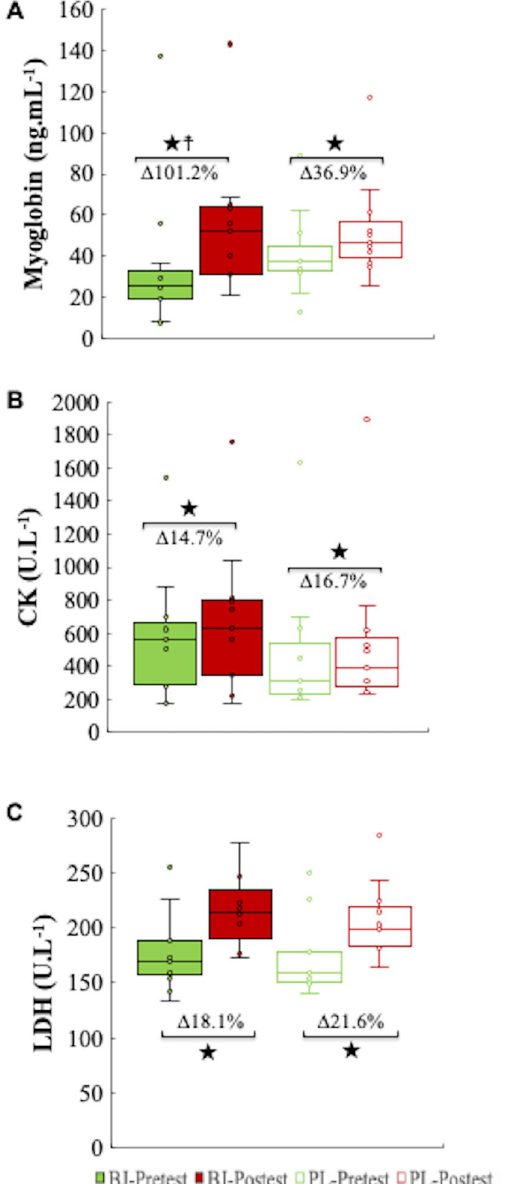
Figure 6. Plasma concentrations of myoglobin ( A ), creatin kinase ( B ) and lactate dehydrogenase ( C ). BJ, beetroot juice; CK, creatin kinase; LDH, lactate dehydrogenase; PL, placebo. ★ A significant increase in post-test compared to pretest in the two experimental conditions (p < 0.05). ☨ Significantly higher increase after BJ intake (101.2%) than in PL condition 36.9% (p <